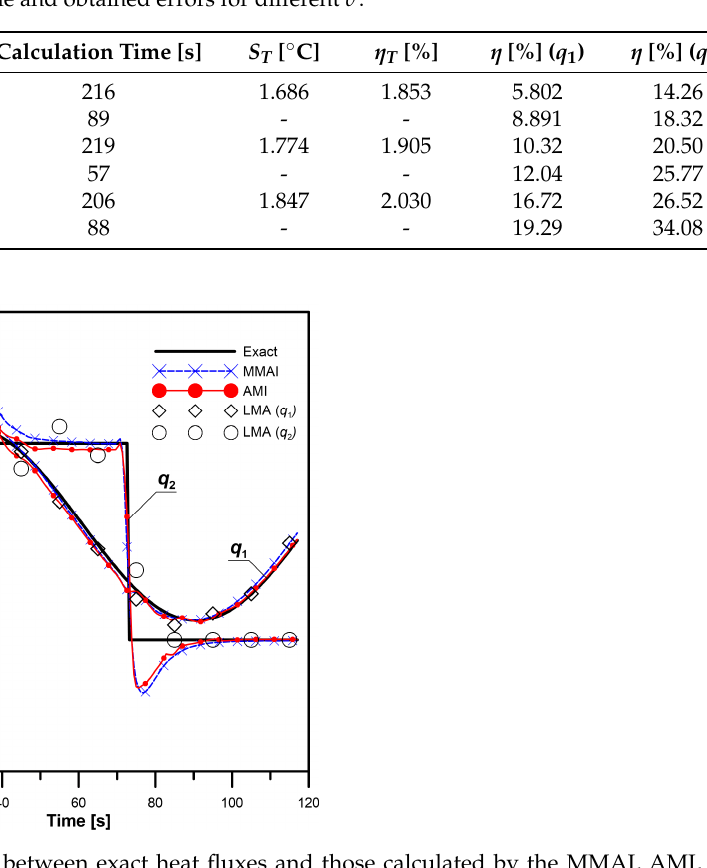
Table 3. Calculation time and obtained errors for different σ .